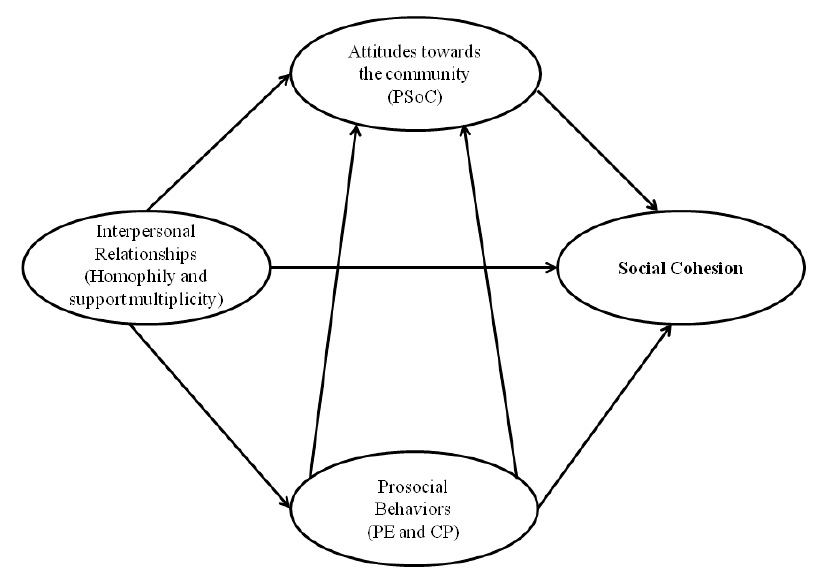
Figure 1. Theoretical model of the constitutive elements of social cohesion. PSoC: psychological sense of community; PE: psychological empowerment; CP: community participation.